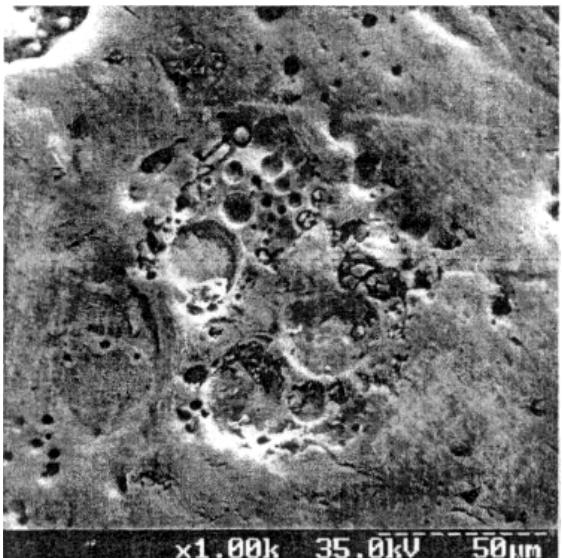
Fig 3. Electronic photo of the coating before experiment